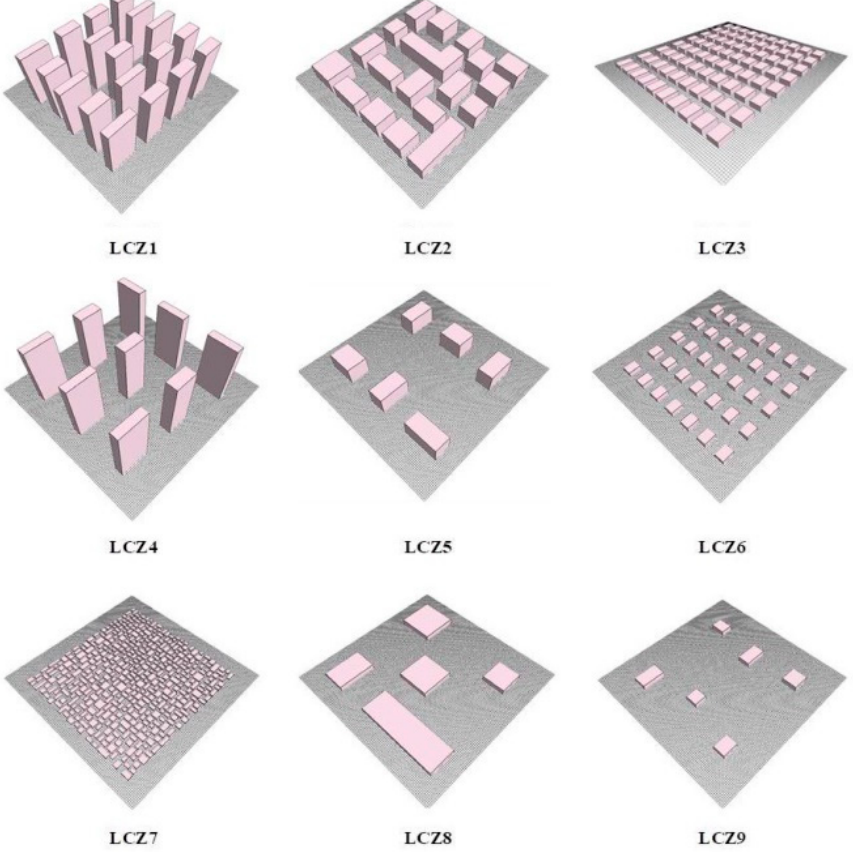
Figure 1. Investigated ideal block models following Local Climate Zone (LCZ) 1–9 classification.